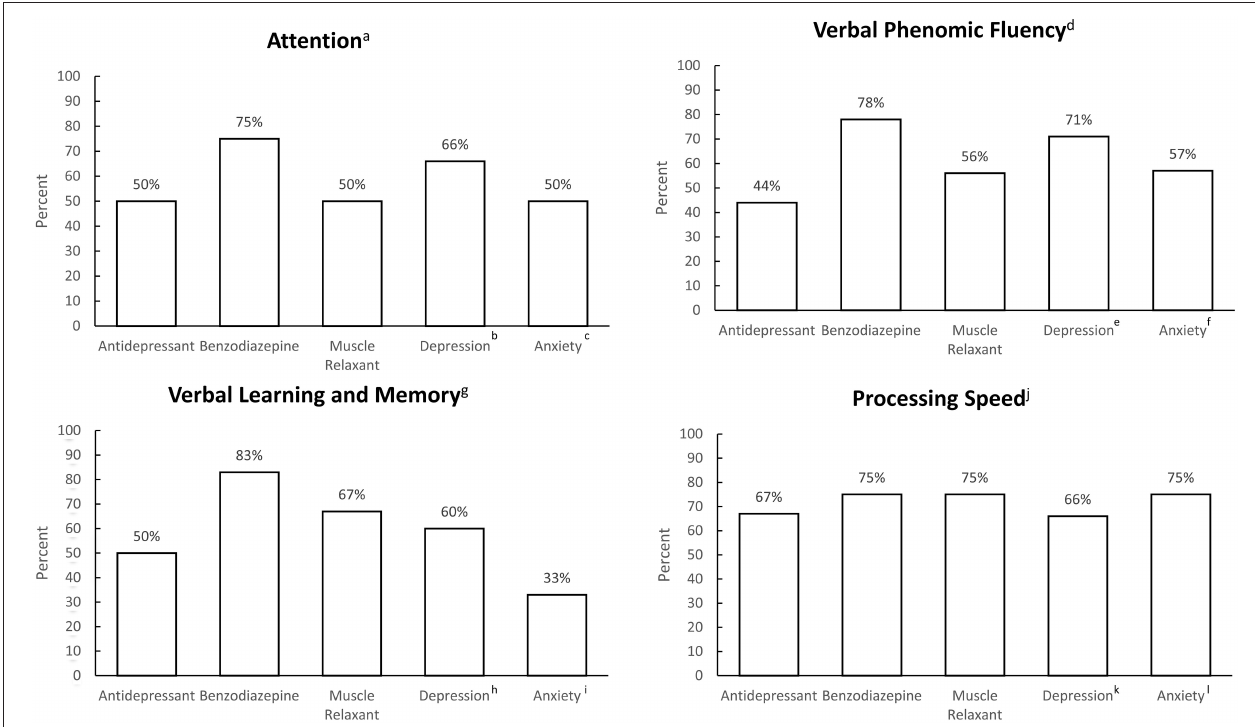
FIGURE 1 | Frequency of antidepressant use, benzodiazepine use, non-benzodiazepine muscle relaxant use, and clinically significant depression and anxiety symptoms, grouped by most commonly impaired cognitive domains. a n = 8, b n = 3, c n = 2; d n = 11, e n = 7, f n = 7; g n = 14, h n = 11, i n = 6; j n = 8, k n = 6; l n =